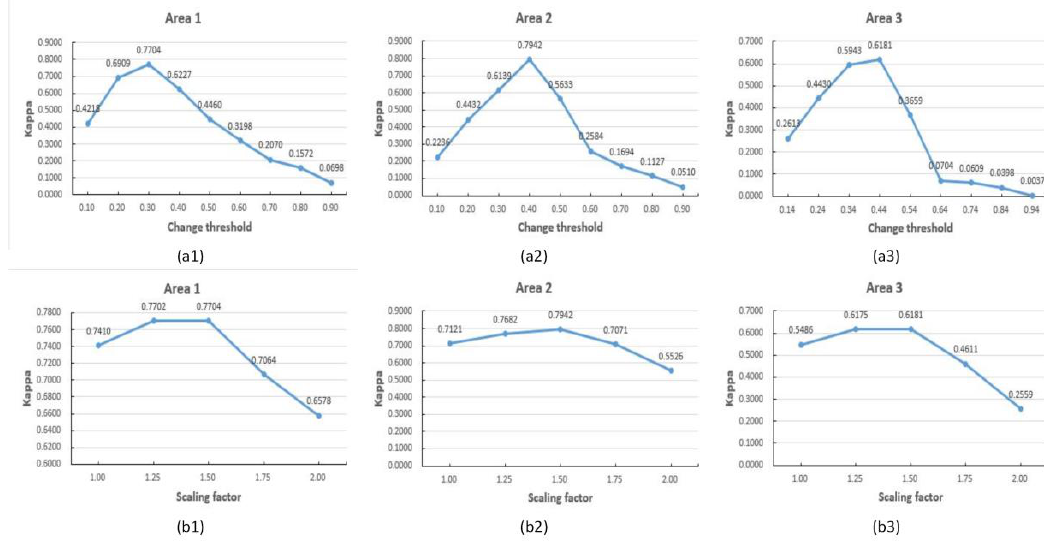
Figure 12. Influences of change thresholds and scaling factor. ( a1 – a3 ) Influences of the change threshold on Kappa in the three experimental areas; ( b1 – b3 ) influences of the scaling factors. change threshold on Kappa in the three experimental areas; ( b1 ), ( b2 ), and ( b3 ) influences of the scaling